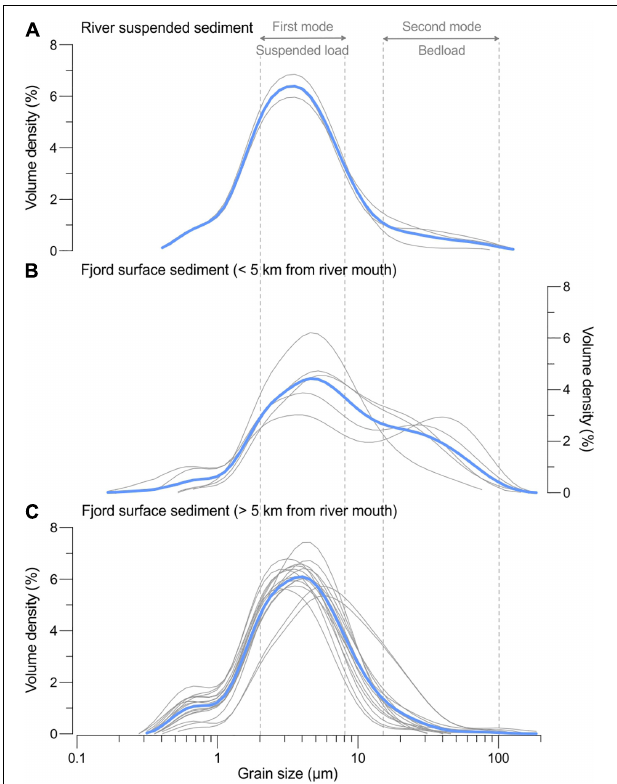
FIGURE 5 | Grain-size distributions of (A) the river suspended sediment samples, (B) the fjord surface sediment samples located less than 5 km from a river mouth, and (C) the fjord surface sediment samples located more than 5 km from a river mouth. The distributions shown in blue represent the average grain-size distribution of each